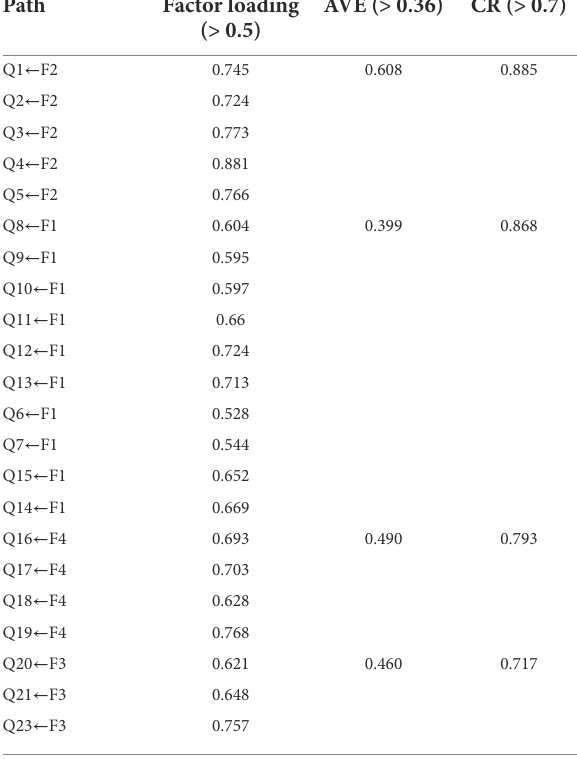
TABLE 4 Convergent validity of the Health Behavior Scale.